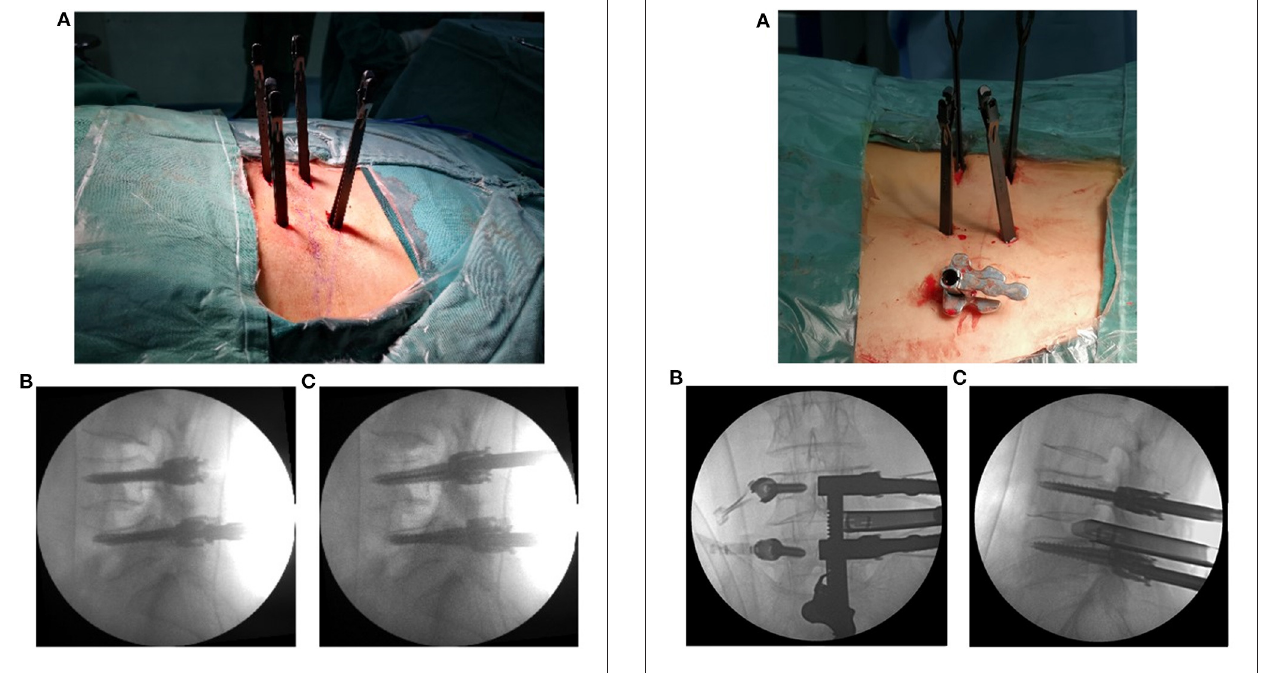
FIGURE 1 | The pedicle screws were placed percutaneously (A) . The positions of the screws are shown in the X-ray lateral view (B) , and the intervertebral foramen was enlarged by a pedicle screw distractor (C)